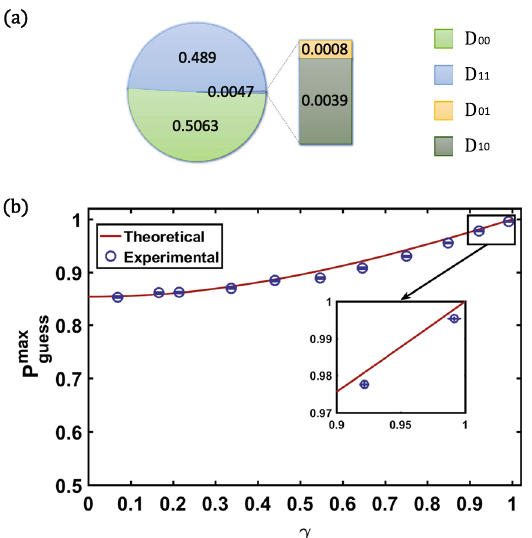
Fig. 4 The experimental results for the d = 2 guessing game. From the experimentally prepared state ρ exp with the maximal purity, we R estimate γ = 0.9918 ± 0.0009. With this γ , we obtain the maximal guessing probability P exp ð γ ; d ¼ 2 Þ ¼ 0 : 9953±0 : 0003 and the guess detected probabilities for each output port are shown in ( a ). In ( b ), we vary the degree of coherence of the register state ρ R to fi nd and γ . The analytical solution is plotted the relation between P max guess as the red line, while the experimental results are given as the blue circles. The x -bars are the standard deviations obtained by repeating the quantum state reconstruction algorithm for input data randomly generated from the experimentally obtained probability distribu- tions. The y -bars are obtained directly from the detection probabilities in D 00 , D 01 , D 10 and D 11 .